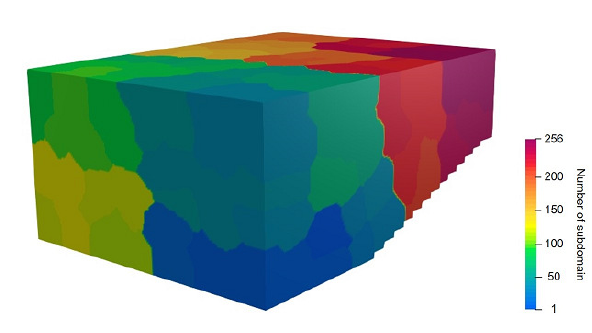
Figure 10. Decomposed auditorium model with 256 subdomains.